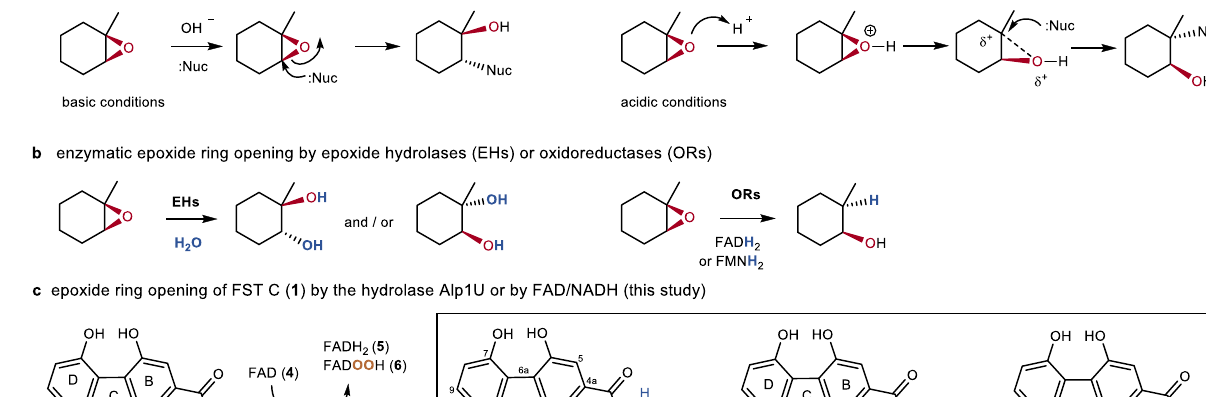
hydrolases (EHs) and oxidoreductases (ORs). c Epoxide ring-opening reactions of fl uostatin C ( 1 ), either enzymatically catalyzed by the hydrolase Alp1U, or none- nzymatically mediated by FAD and NADH as reported in this